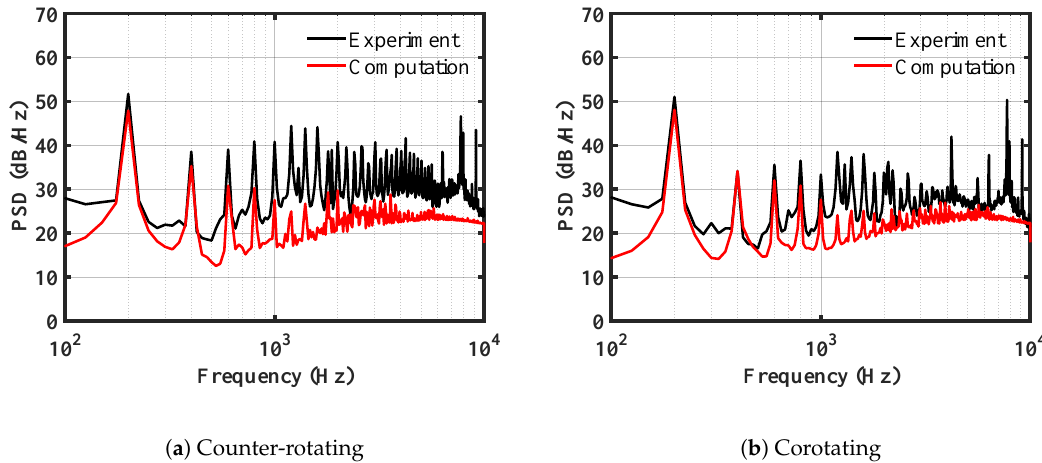
Figure 18. Direct comparison of computational and experimental acoustic spectra of the dual rotors with a separation distance of t = 0.04 at Mic 3 of the linear